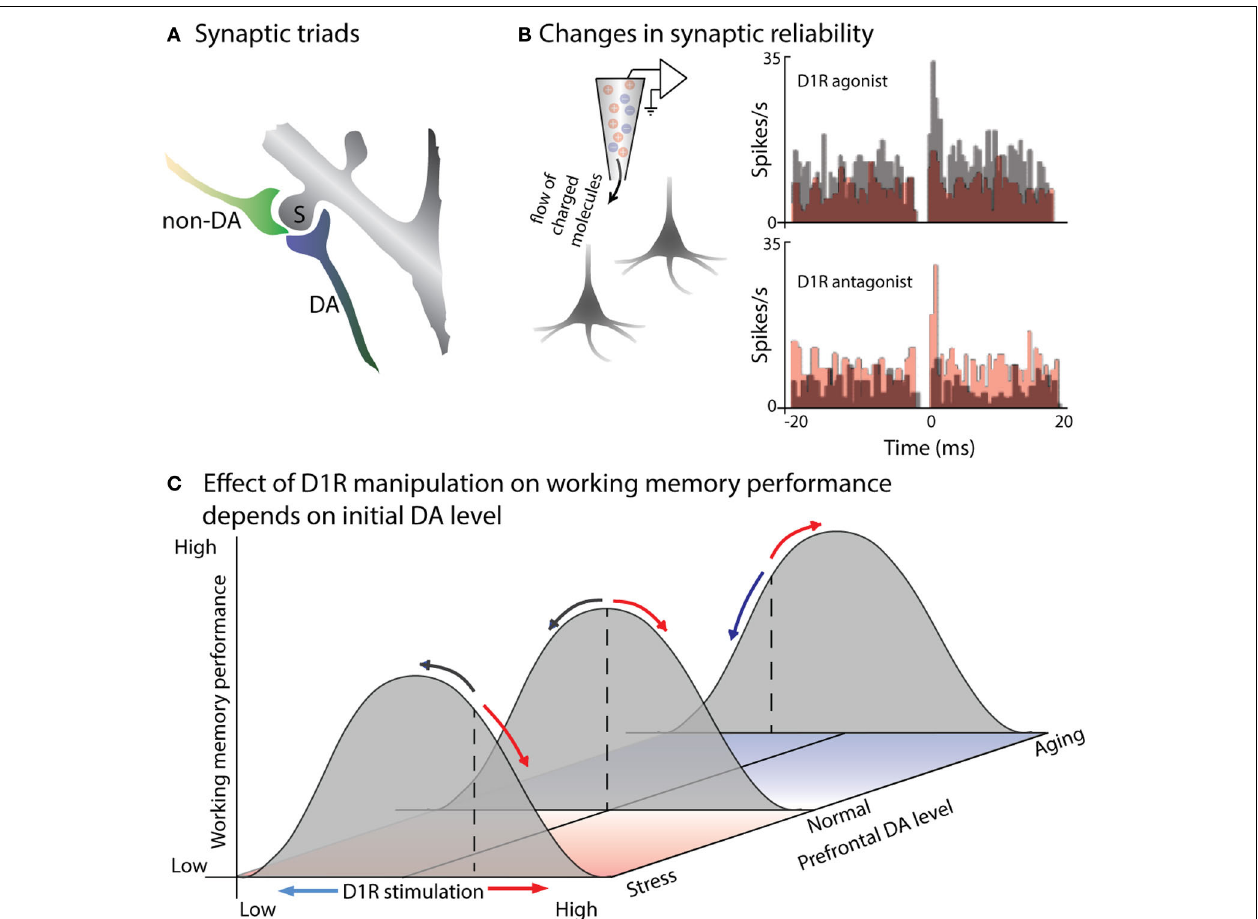
FIGURE 1 | DA modulates the efficacy of synaptic connections within PFC. (A) Cartoon illustrates a characteristic “synaptic triad” in monkey PFC: the same spine (S) is postsynaptic to both a DA-positive axon (DA) and a non-immunoreactive axon terminal (non-DA). The synapse of the DA axon is symmetric, while the non-DA axon forms an asymmetric synapse. Based on electron micrography and immunostaining of synaptic connections in layer II of monkey PFC (from Goldman-Rakic et al., 1989). (B) D1R signaling alters synaptic efficacy, a measured by changes in the synchronous firing of pairs of PFC neurons. Castner and Williams (2007) simultaneously recorded from pairs of neurons in monkey PFC before and after delivering a D1R agonist or antagonist using in vivo iontophoresis. Cross-correlograms depict the number of spikes occurring at a particular time-lag relative to spikes of the other neuron in the pair: a peak at 0ms indicates simultaneous firing due to common input. The top pair of PFC neurons exhibited a 0ms peak prior to drug infusion (gray): application of a D1R agonist eliminated this peak (red), presumably by disrupting the efficacy of common input. In the bottom plot, the neurons did not show evidence of common input during the control